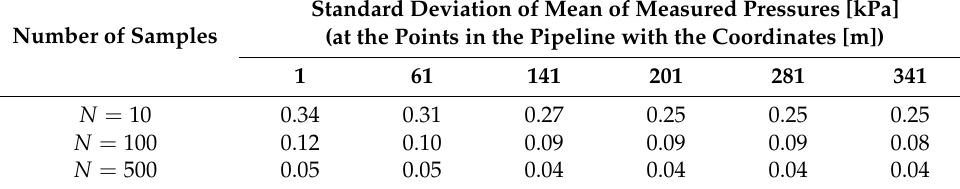
Table 4. Approximated results of standard uncertainties of type A. Standard Deviation of Mean of Measured Pressures Number of Samples